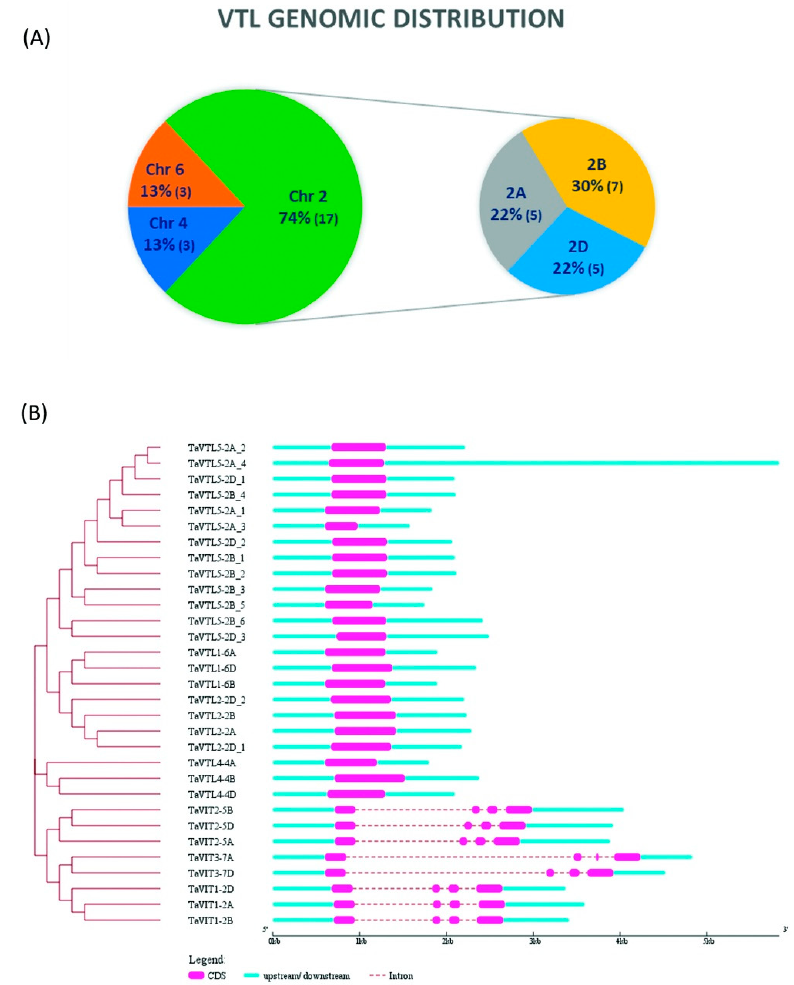
Figure 2. Genomic distribution and exon intron arrangements of VTL genes. ( A ) VTL genes genomic distribution. Wheat VTL genes were present on chromosome groups 2, 4 and 6 with maximum VTL genes on chromosome group 2, which was selected to show the VTL gene distribution on 2A, 2B and 2D chromosomes. ( B ) Genomic structure for wheat VTL and VIT genes. The intron-exon arrangement was identified using Gene Structure Display Server (GSDS). Exons and introns are represented using pink boxes and cyan lines, respectively. The scale determines the size of the genomic regions.